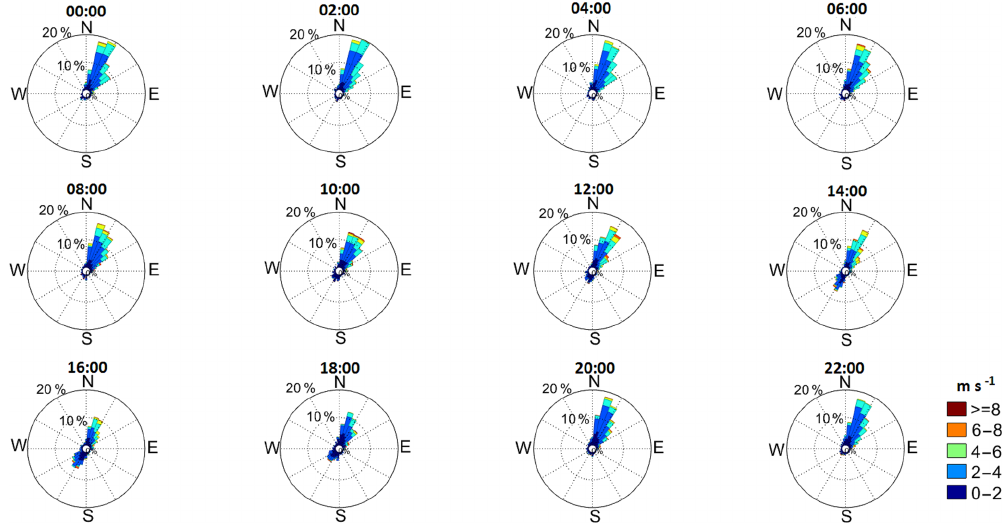
Figure 4. Wind roses showing the hourly wind direction and the wind speed frequency at AWS1 (local